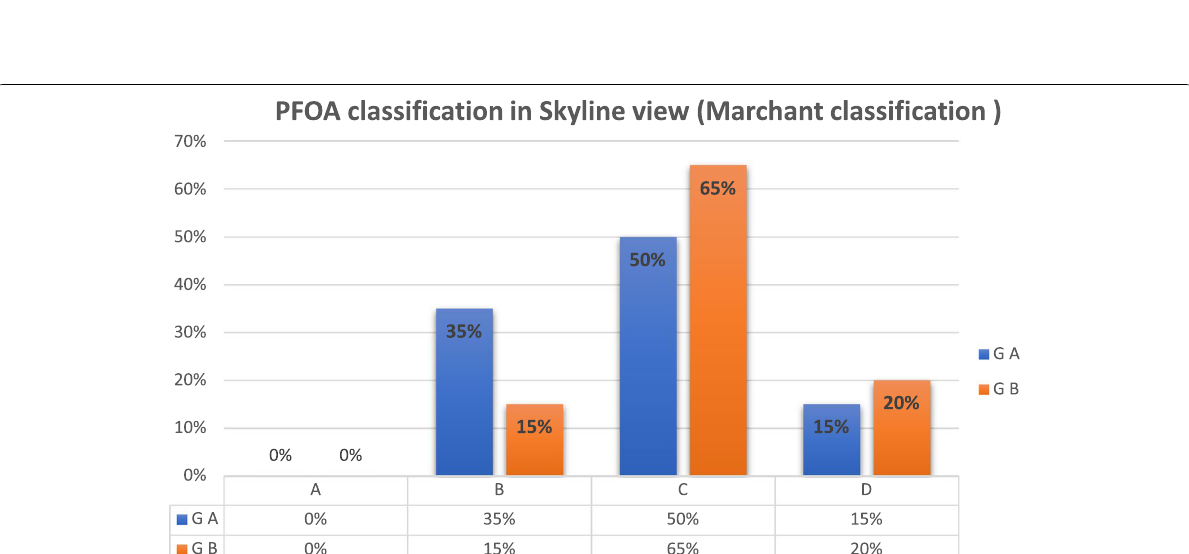
Fig. 13 Preoperative patellofemoral joint osteoarthritis classification in the skyline view x‑rays (Merchant classification) of both groups